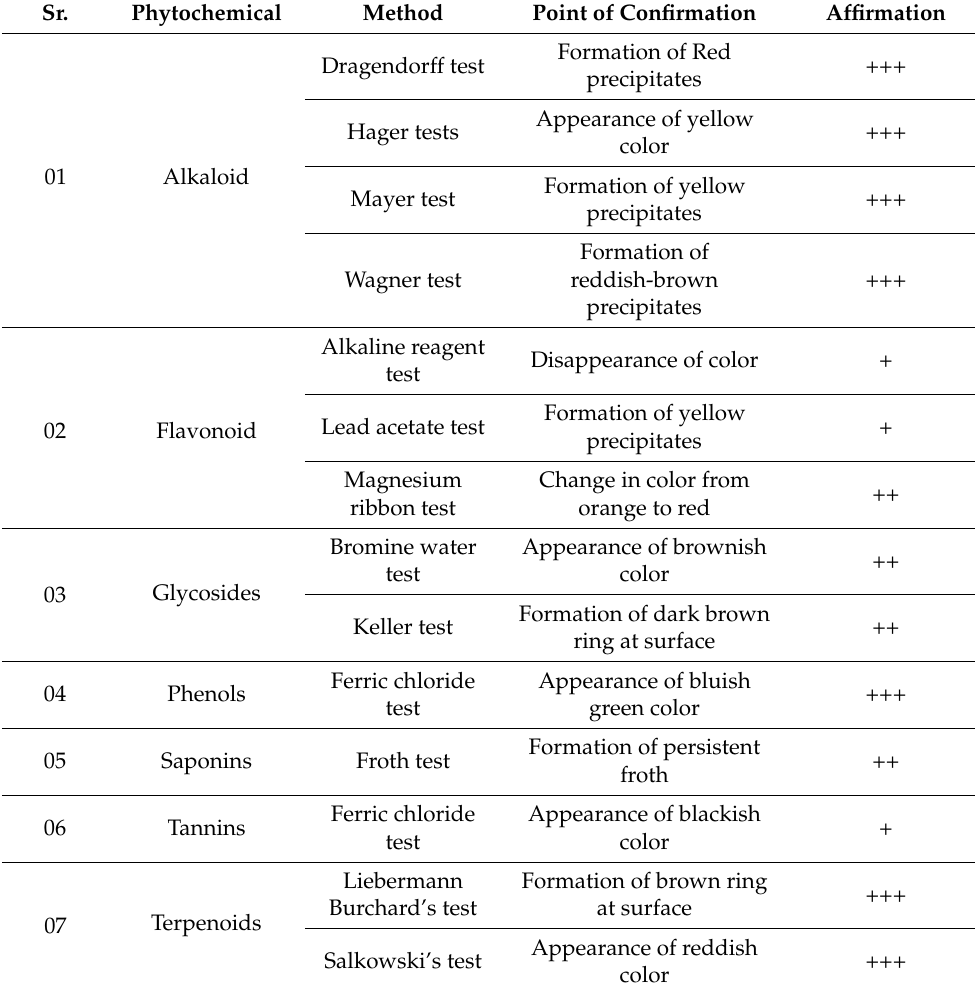
Table 1. Phytochemical analysis of C. colocynthis ethanolic fruit extracts.